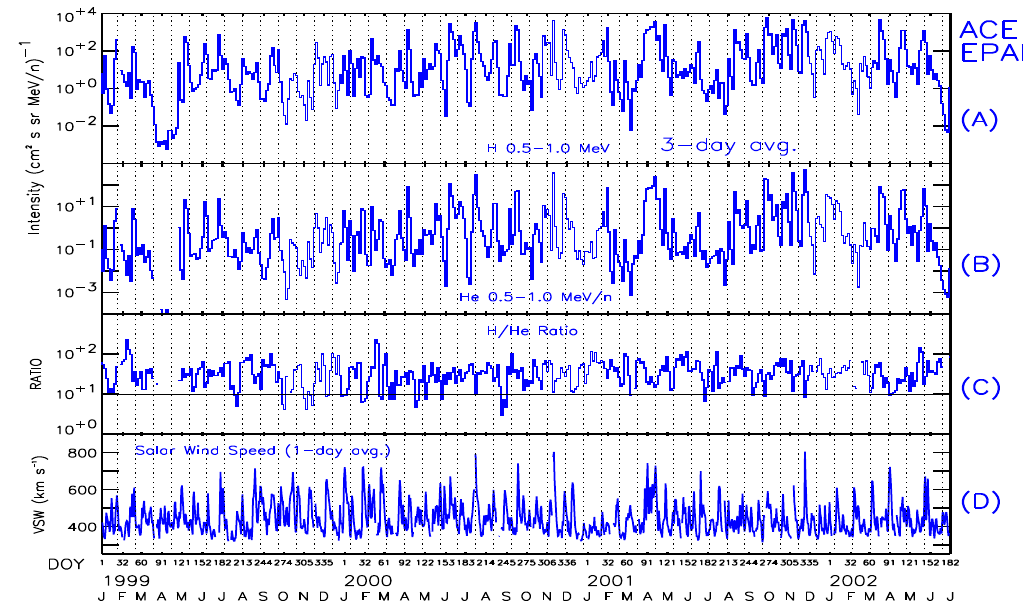
Fig. 6. Three-day averages of the (A) 0.5–1.0MeV proton intensity and (B) 0.5–1.0MeV/nucleon helium intensity as measured by the EPAM instrument on ACE (Gold et al., 1998). (C) H/He ratio calculated from the H and He traces shown in panels A and B. (D) Daily averages of the solar wind speed as measured by the SWEPAM instrument on ACE (McComas et al., 1998). The time interval extends from 1 January 1999 to 1 July 2002. The vertical dotted lines are spaced every 27 days. The horizontal line in panel (C) marks a value of H/He ratio = 10.